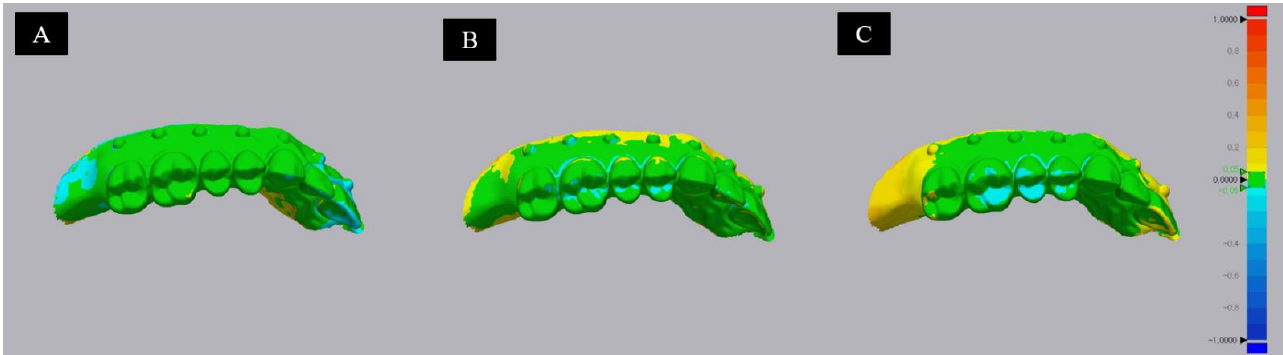
Figure 4. Representative images of a color map for assessing the trueness of the IOS. ( A ) Trios 3, ( B ) CS3600, ( C ) i500. Trios shows a slight deviation on the occlusal surface. In CS3600, the minus deviation is observed in the central groove area. In i500, the minus deviation is mainly located on the inclined plane of the cusp. In color map analysis, maximum range was 1.0 mm, minimum range was 1.0 mm and tolerance level was ±0.05 mm.